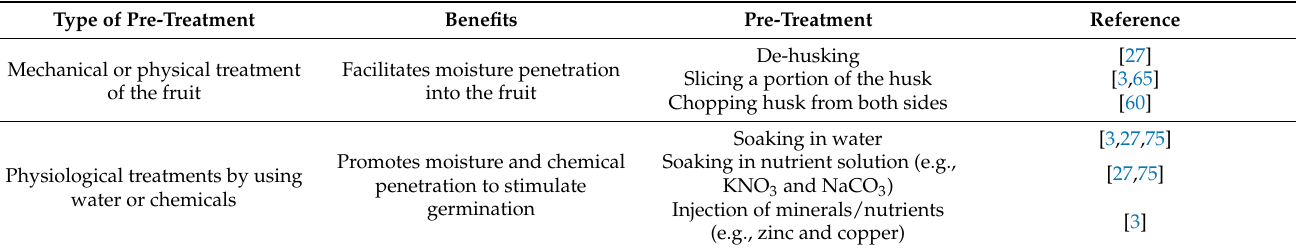
Table 1. Pre-treatment techniques to promote coconut fruit